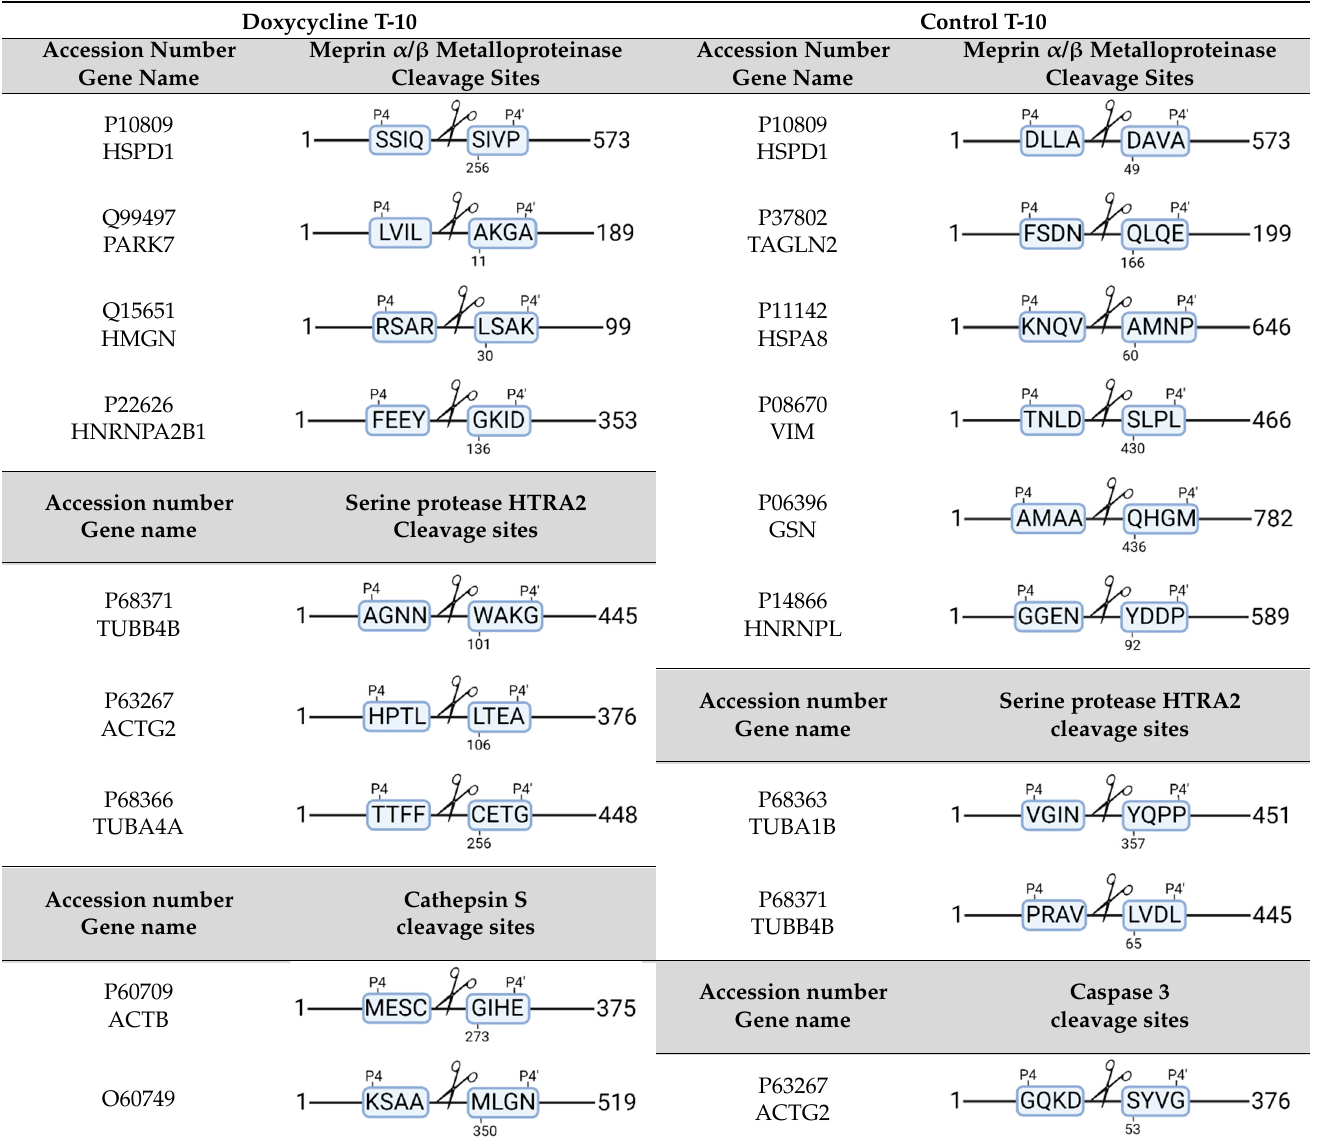
Table 2. Proteases identified in experimental groups and their proteolytic activity.